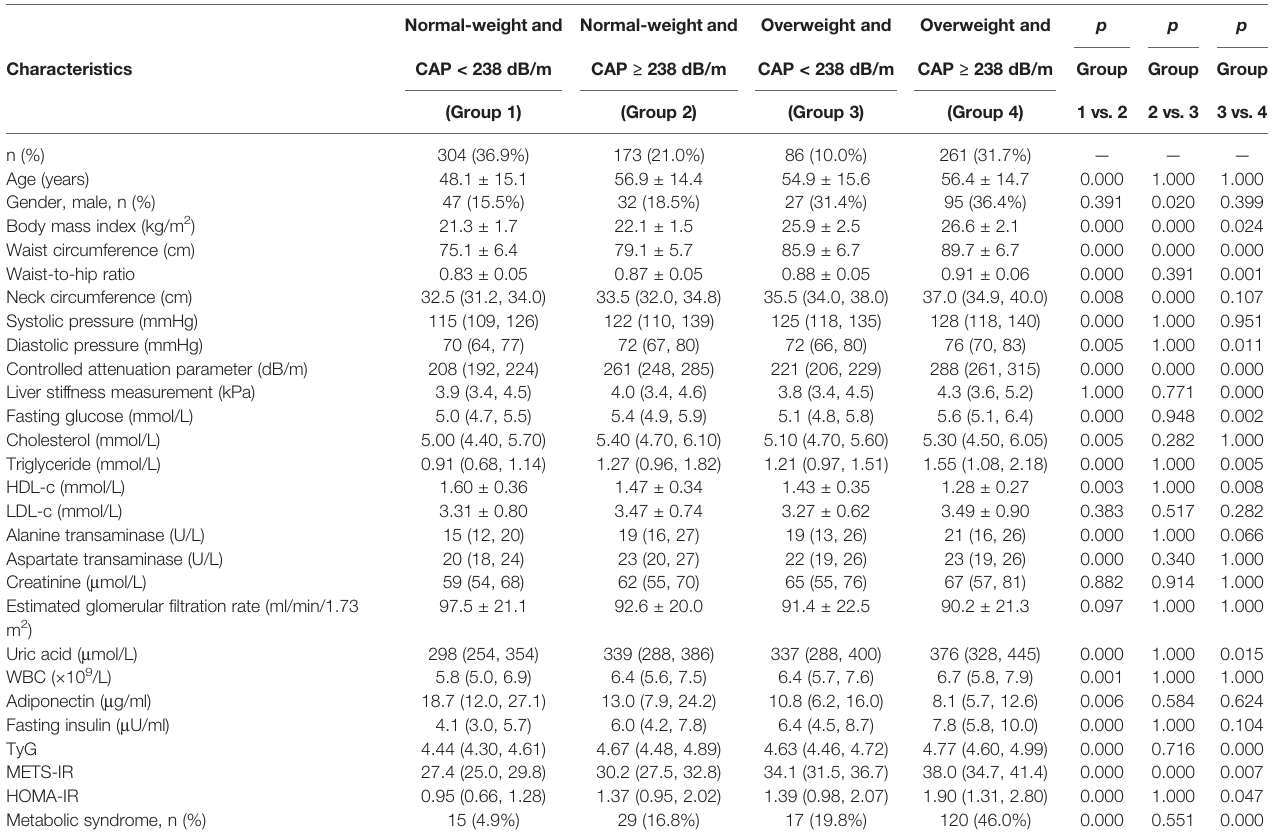
TABLE 4 | Clinical characteristics in normal-weight versus overweight subjects with or without hepatic steatosis. Normal-weight and Normal-weight and Overweight and Overweight and p p p